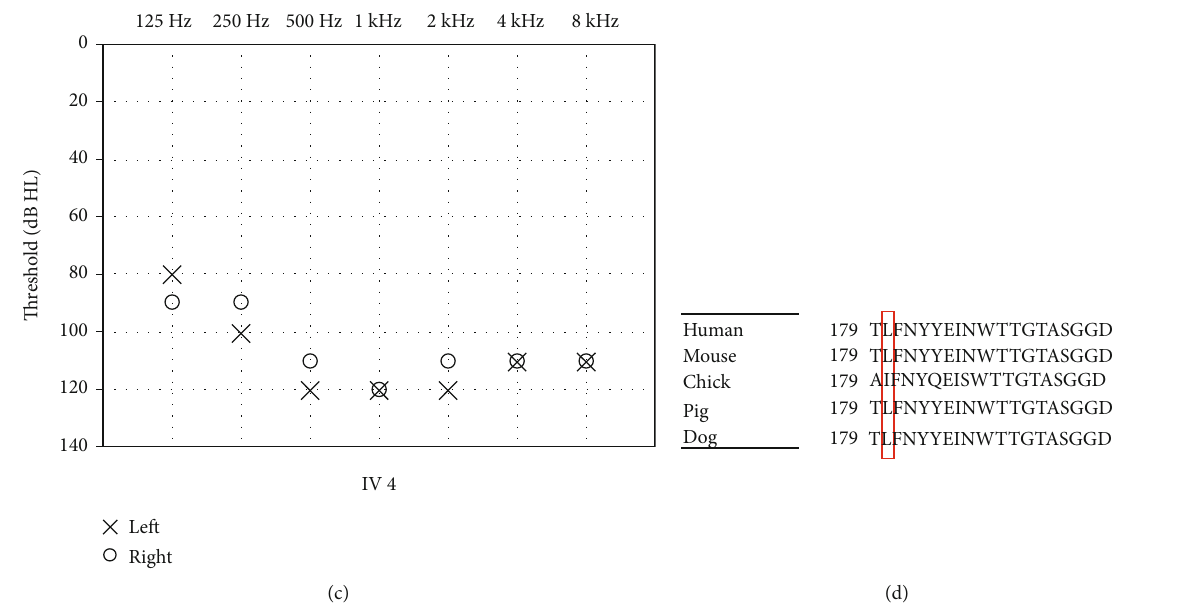
Figure 1: Genetic and phenotypic characterization of Family PK-DD-KA-01. (a) Pedigree and genotype showing the c.536del (p. Leu180Serfs ∗ 20) variant in TECTA . (b) Sanger sequencing of the c.536del (p. Leu180Serfs ∗ 20) variant in a ff ected and una ff ected family members. (c) Pure tone audiometry showing the bilateral profound hearing loss in a ff ected family member IV-4. (d) Multiple sequence alignment showing the conservation of the L180 residue in di ff erent